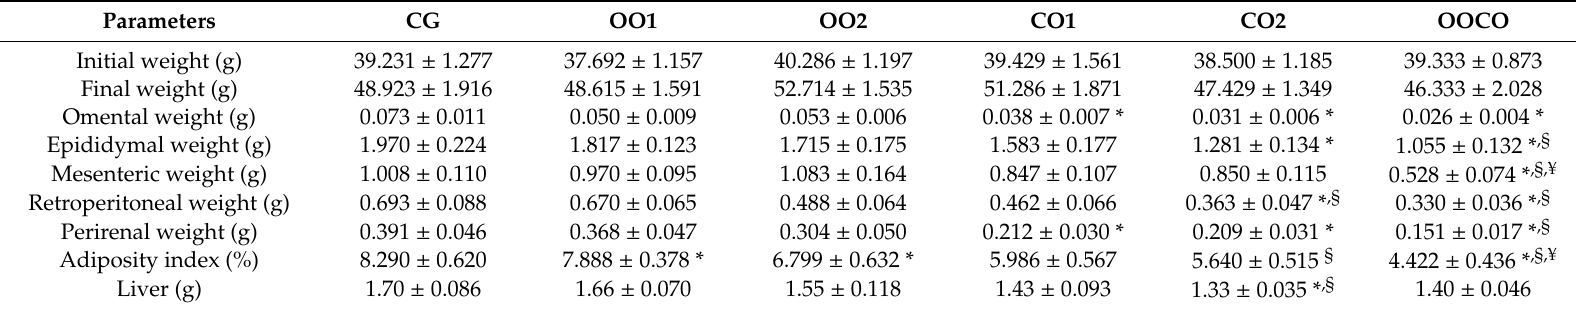
Table 4. Bodyweight, liver, and visceral fats weight (g) of animals supplemented with di ff erent lipid